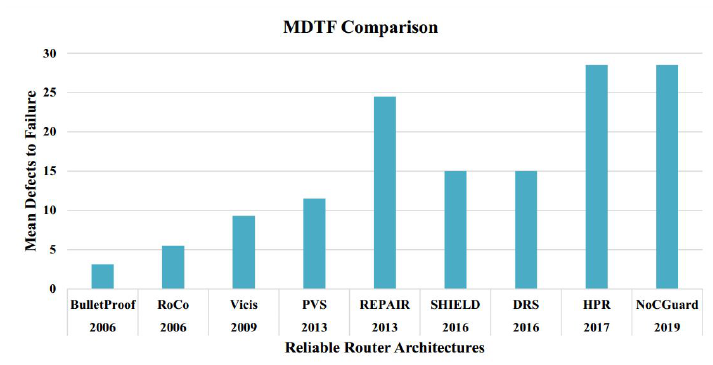
Figure 10. MDTF Comparison.